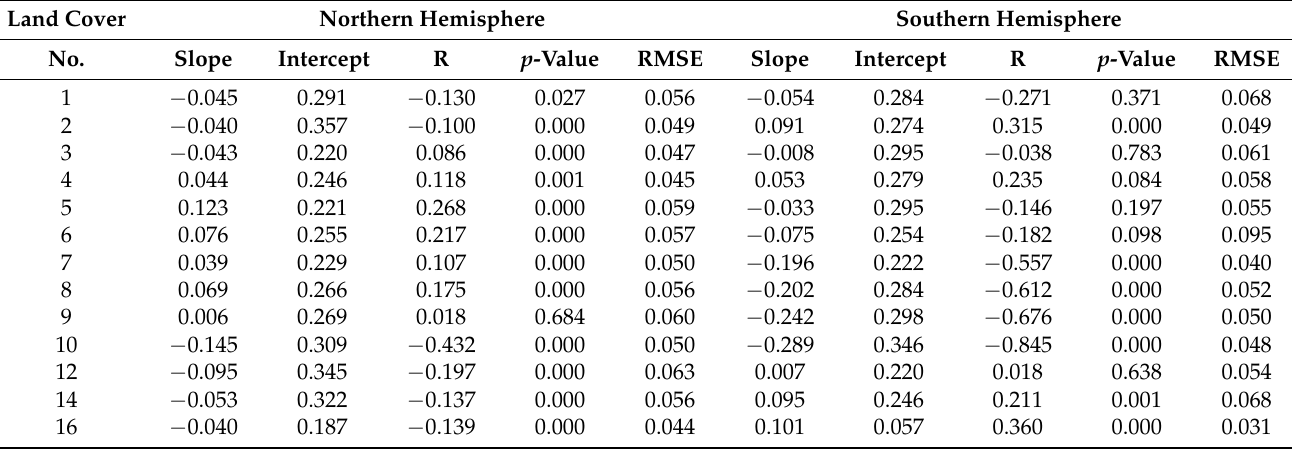
Table 5. Conversion coefficients and their statistics (R, p -value, RMSE) for TVDI and SM for 16 land cover types on